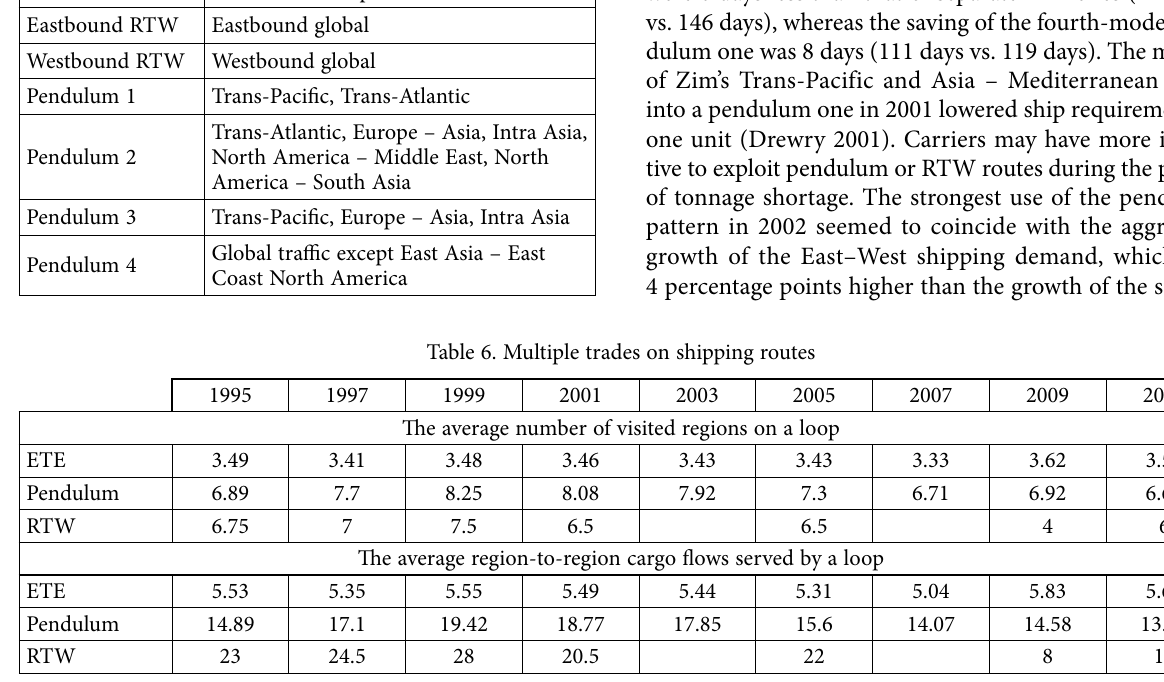
Table 5. Captive trades of RTW and pendulum routes Pattern Captive